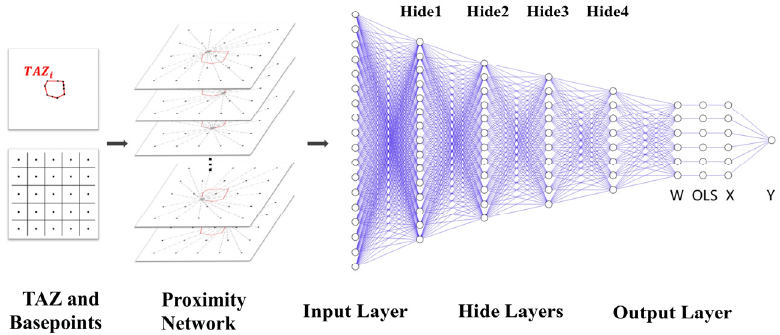
Figure 6. Structure of PBNNWR model.